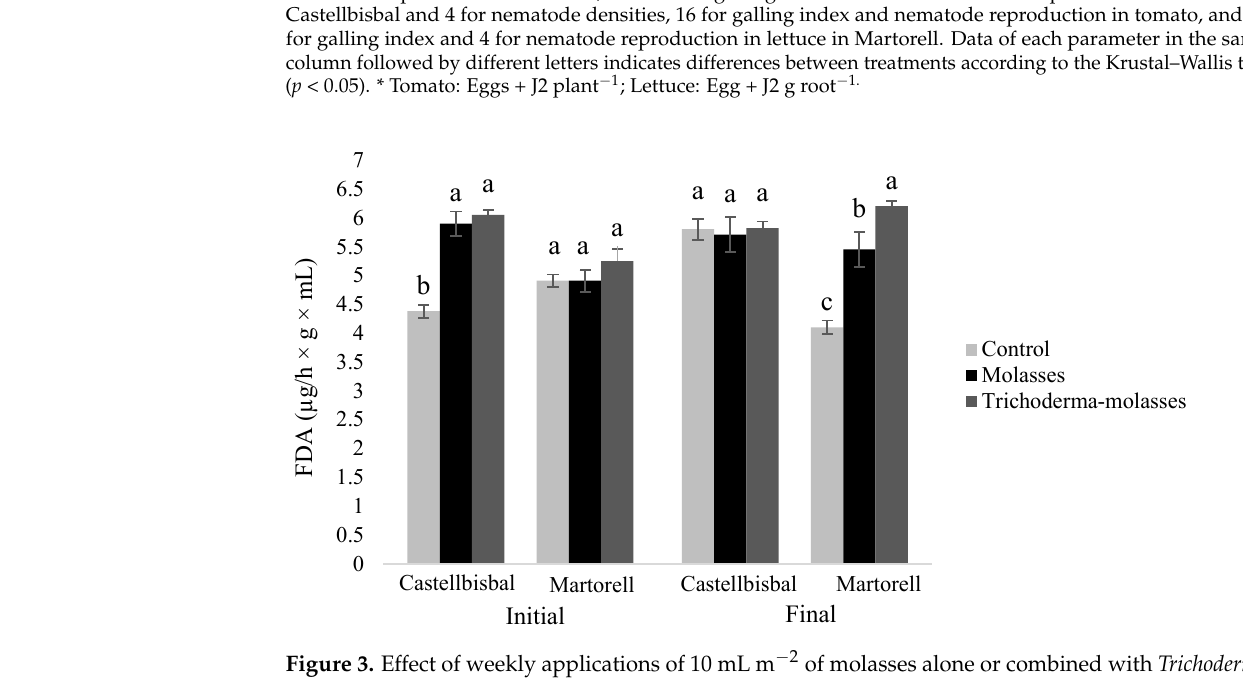
Figure 3. Effect of weekly applications of 10 mL m − 2 of molasses alone or combined with Trichoderma asperellum T34 on the microbial activity (FDA) in the soil, at the beginning and at the end of the crop in two organic vegetable production sites. Data are presented as mean ± standard error of 5 repetitions in Castellbisbal and 4 in Martorell. Data within each site and period followed by different letters indicates differences between treatments according to the Krustal–Wallis test ( p < 0.05).